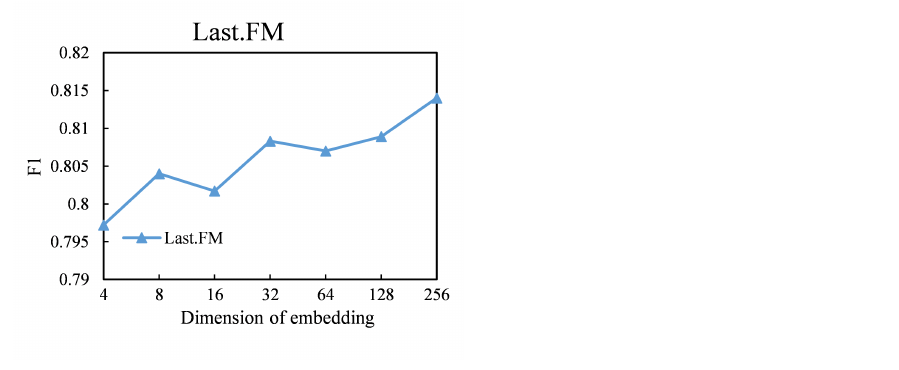
Figure 5. Comparison of the F1 performance on different embedding dimensions in Last.FM.